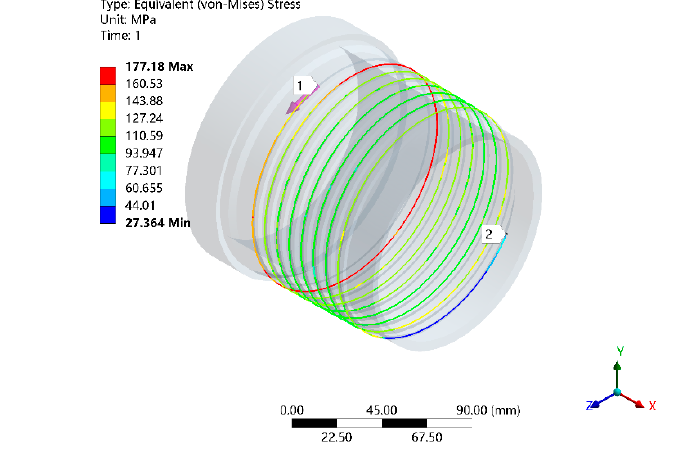
Figure 10. Stress path setting.